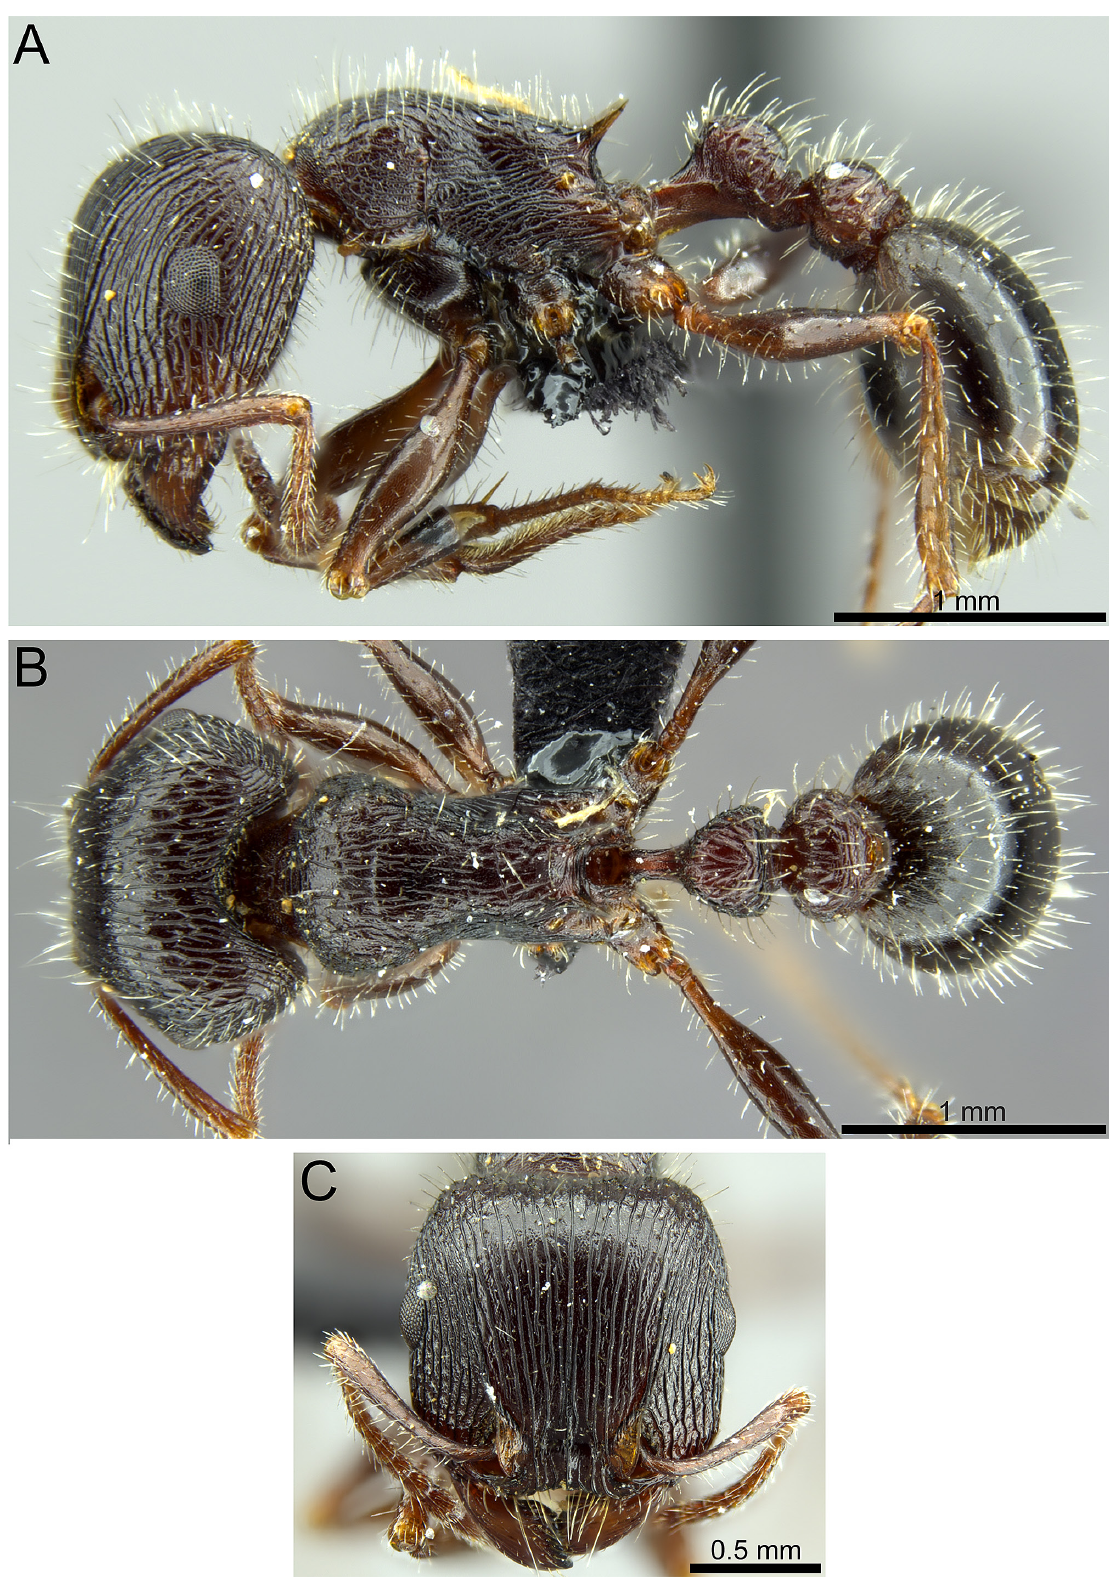
Fig. 16. Tetramorium margueriteae Mbanyana, Robertson & Hita Garcia sp. nov. (SAM-HYM-C019839). A . Body in profile. B . Body in dorsal view. C . Head in full-face